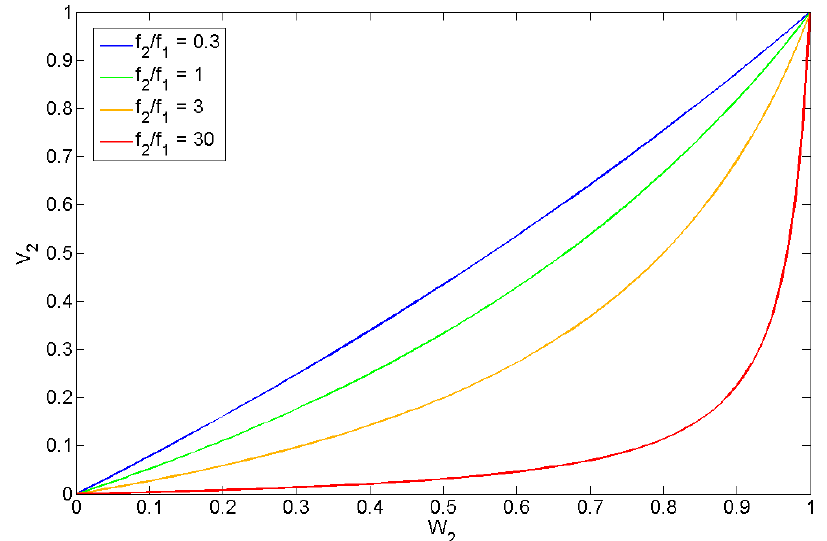
Figure A2. The ratio between w 2 и v 2 versus of f 2 / f 1 . Table A1. De-biased number of light planets depending on applied method ( W or V matrices). Table A2. List of considered RV planets (shading at FGK